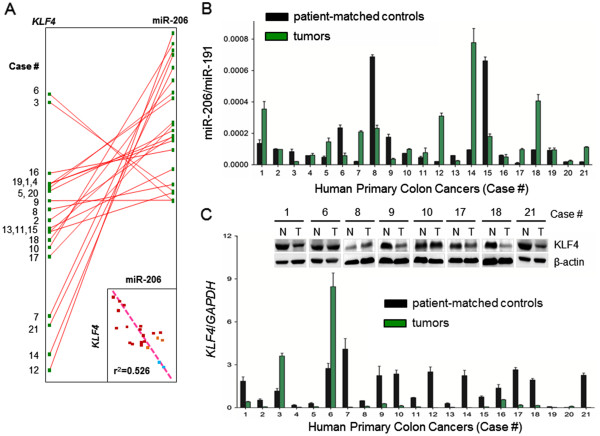
Inverse association between miR-206 and KLF4 in human colon cancers. (A) Twenty-one human primary colon cancers were examined for KLF4 mRNA expression normalized to GAPDH, and for miR-206 normalized to miR-191. Inset: the inverse correlation was significant, r2 = 0.525, P < 0.05. (B) Expression of miR-206/miR-191 in 21 primary colon cancers and their patient-matched controls. (C) Expression of KLF4/GAPDH mRNA in the same tumors and matched controls. Representative Western immunoblots are also shown for KLF4 protein normalized to β-actin.